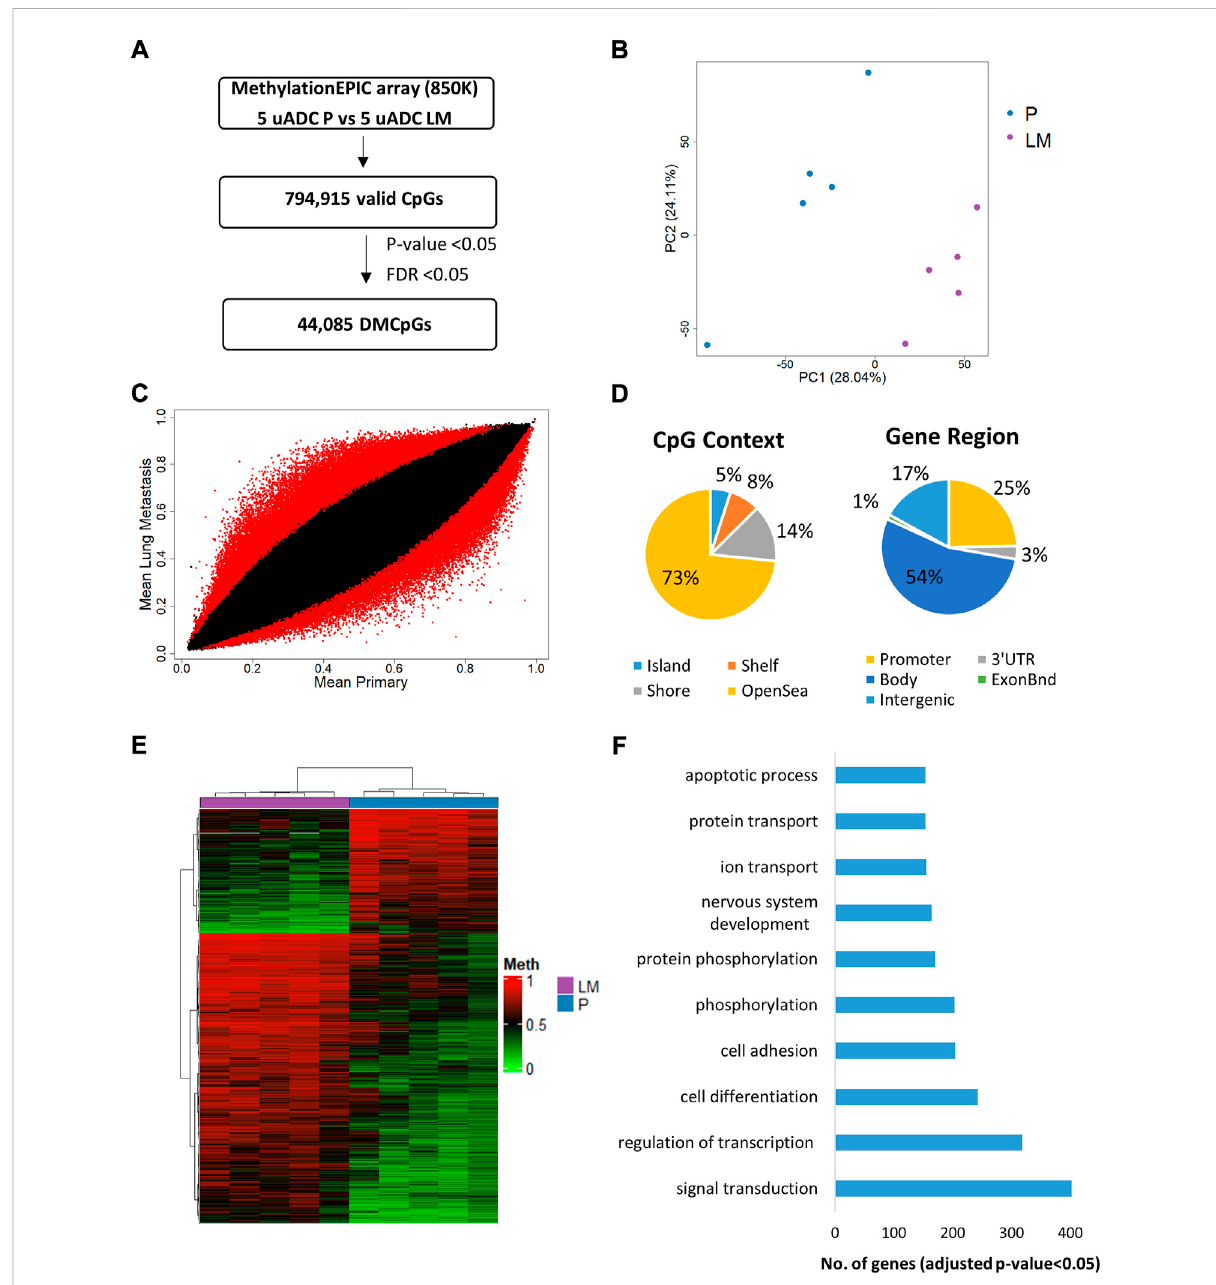
FIGURE 6 Genome-wideDNAmethylationanalysisoftheITFinpairedtumorsofuADCpatients. (A) Schematic fl owchartusedtoidentifysigni fi cantdifferentially methylatedCpGsattheITF. (B) Principalcomponentanalysis(PCA)ofDNAmethylationdataattheITF. (C) Scatterplotrepresentingmeannormalizedlevels of DNA methylation ( β -values) at the ITF of primary tumors and lung metastasis. Dots in red show signi fi cant differentially methylated CpGs. (D) Genomic distribution of the 44,085 signi fi cant differentially methylated CpGs at the ITF by CpG context and gene region. (E) Hierarchical clustering of the 10,000 most differentially methylated CpGs (FDR < 5%) in the ITF of primary and lung metastasis of uADC patients. (F) Gene ontology (GO) analysis of the biological process categories for the 10,000 most differentially methylated CpGs in the ITF of primary and lung metastasis of uADC. DMCpGs, differentially methylated CpGs; Meth, DNA methylation; P, Primary tumors; LM, lung metastasis, uADC, uterine